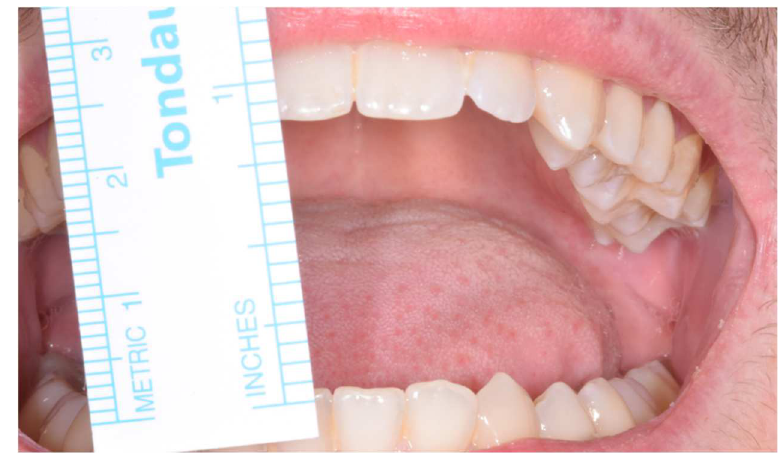
Figure 10. MMO of 20 mm at first clinical examination.